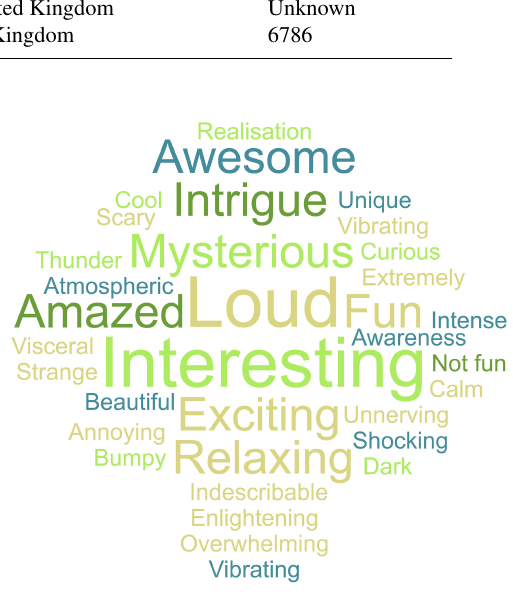
Figure 11. A word cloud summarising the words used to describe the hertz project by the public during its